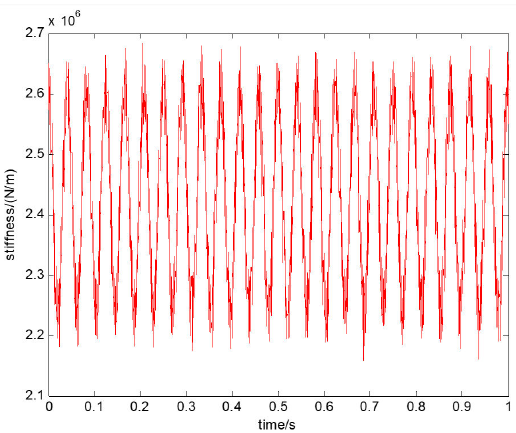
Figure 17. Time domain diagram of the horizontal stiffness variation of the square shaft